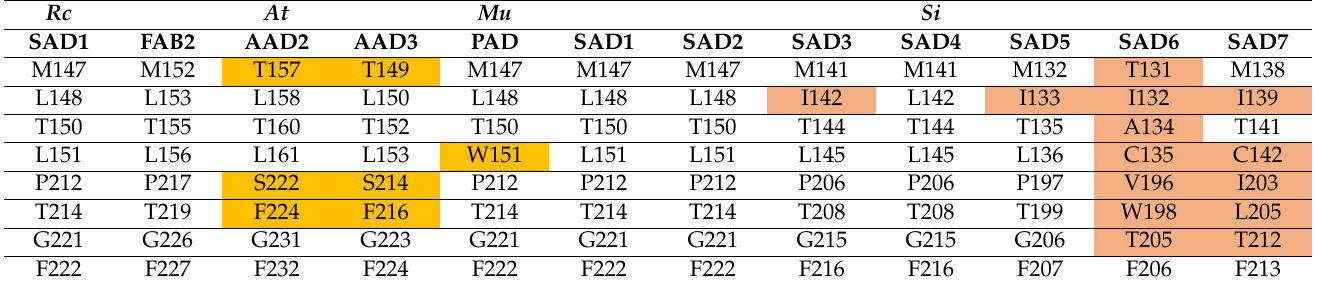
Table 2. Comparison of the amino acid residues of the catalytic sites of Si SADs with cell highlights showing a different AA when compared to Rc SAD1 and At FAB2